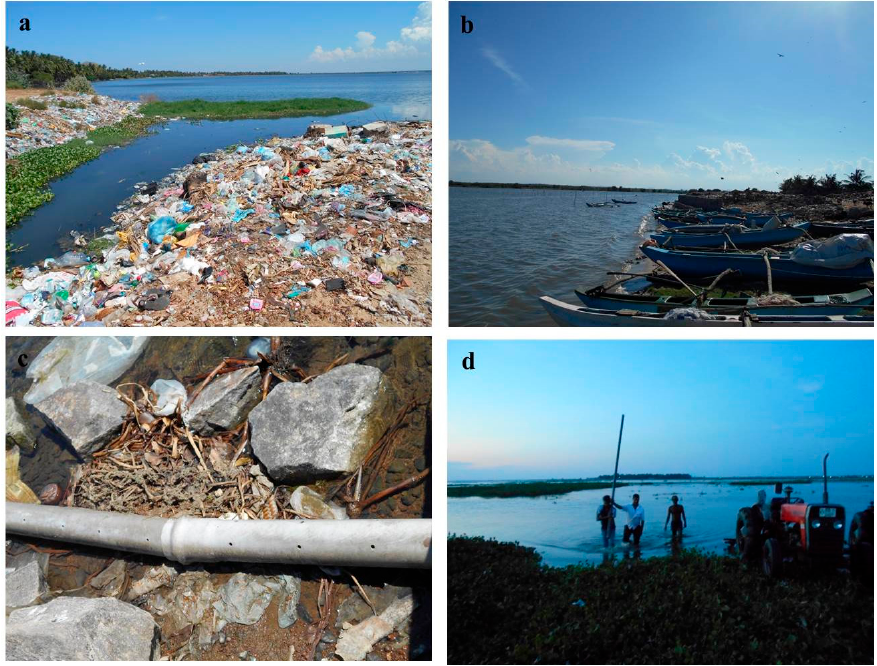
Figure 2. ( a ) Municipal waste disposals of Eravur ( b ) household and fishing contaminations in Kaththankudi ( c ) local toilet drain pipes of Kaththankudi ( d ) vehicle service stations are directly disposed to the lagoon water at Kalmunei